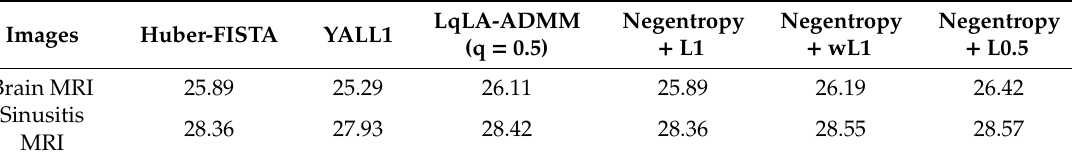
Table 4. Comparison of PSNR (dB) values obtained by di ff erent methods under Gaussian mixture model (GMM)